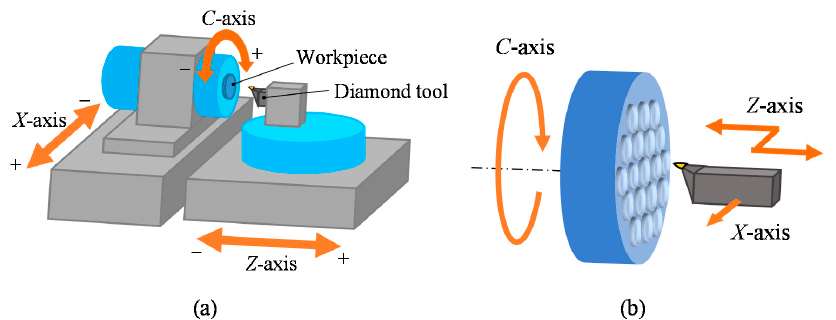
Figure 1. Schematic of slow tool servo (STS) diamond turning: ( a ) lathe configuration; and ( b ) freeform machining.